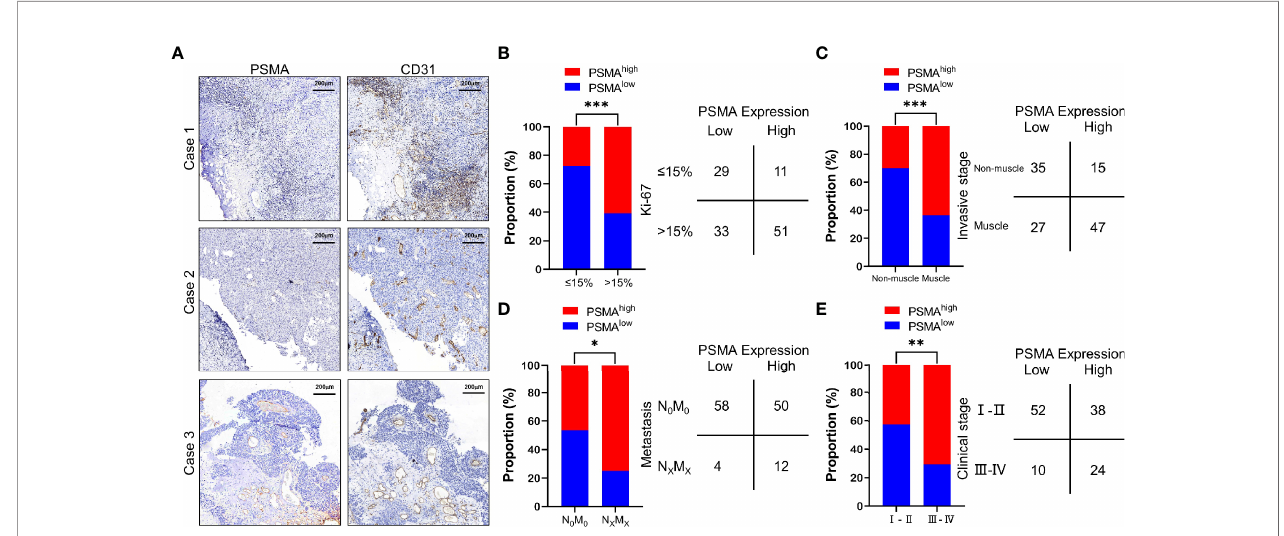
FIGURE 1 | PSMA expression in the tumor-associated vasculature of UCB and the comparison with clinicopathological parameters. (A) Representative IHC staining to show different PSMA expression levels in HCC, using CD31 as the positive control. Case 1: No PSMA expression (score = 0), Case 2: Positive PSMA expression in ≤ 50% of the tumor-associated vasculature (score = 1), and Case 3: Positive PSMA expression in >50% of the tumor-associated vasculature (score = 2). (B) Comparison between PSMA expression and the Ki-67 index. (C) Comparison between PSMA expression and invasive stage. (D) Comparison between PSMA expression and metastasis. (E) Comparison between PSMA expression and clinical stage. Scale bar = 200 m m. Representative images are shown. *P < 0.05; **P < 0.01; ***P < 0.001.